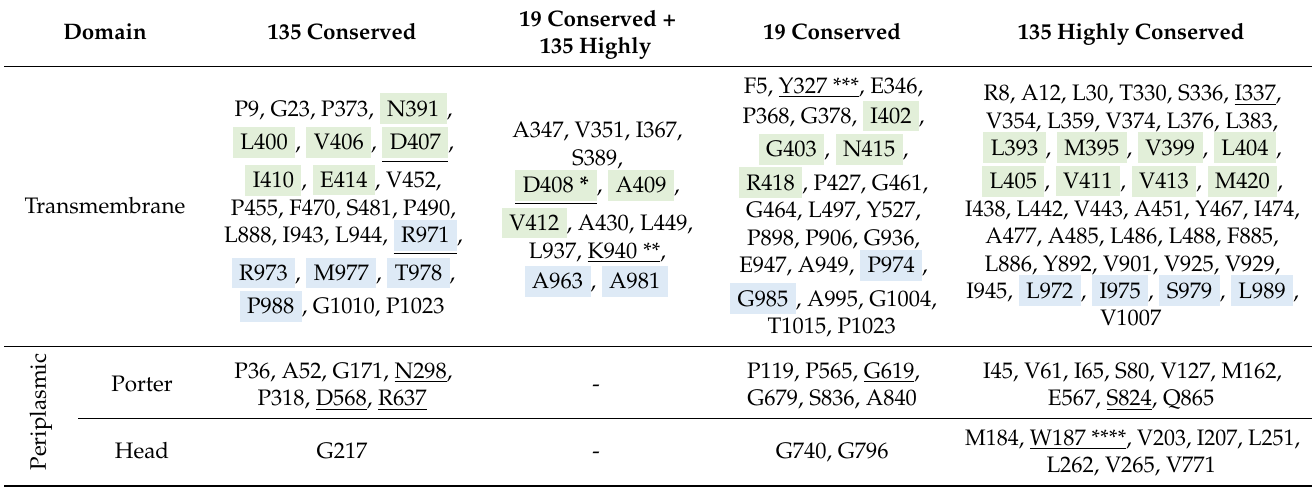
Table 2. Conserved residues based on 135 RND-type efflux pumps.